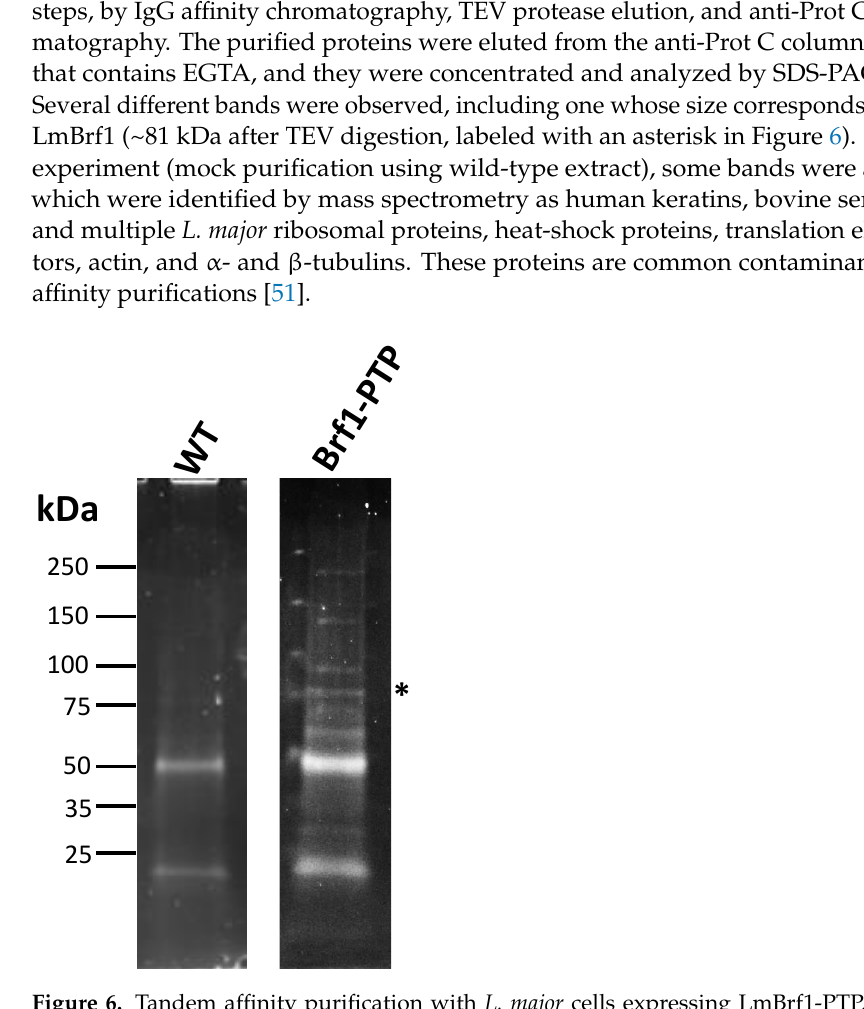
Table 1. Proteins that co-purified with LmBrf1 a